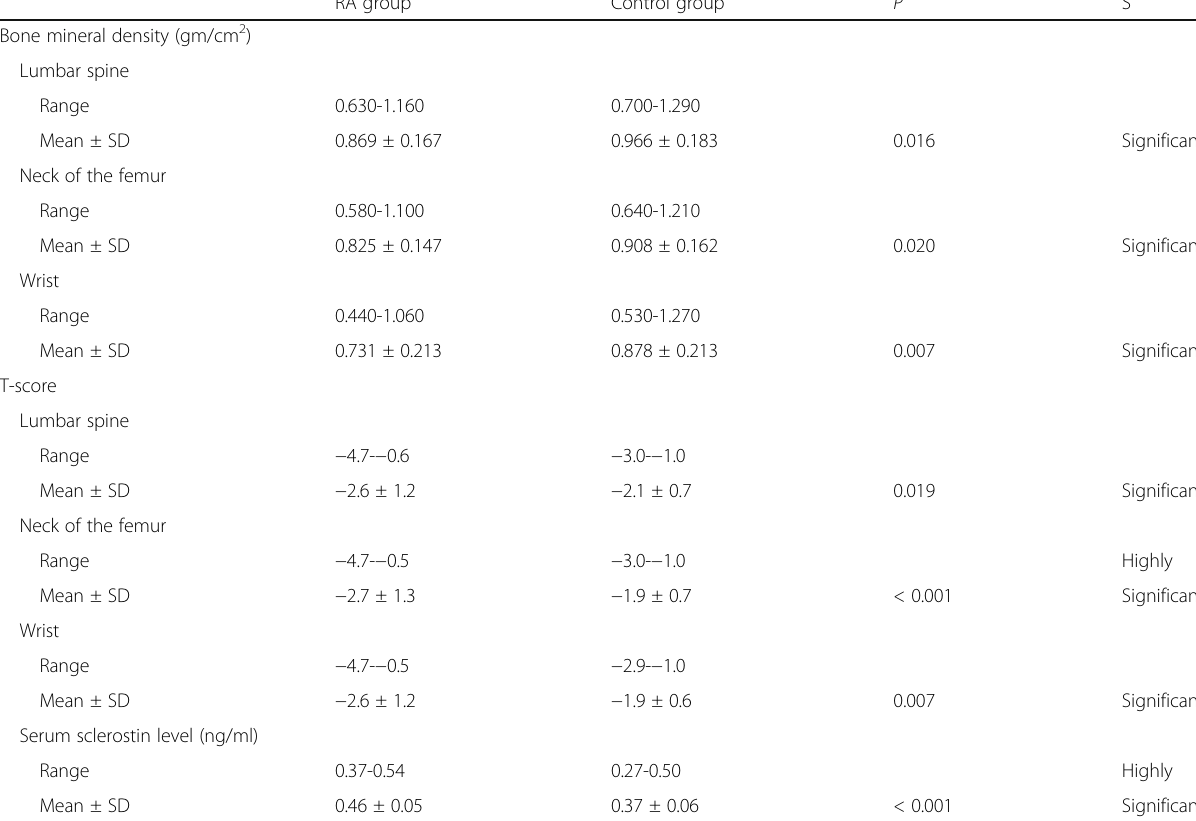
Table 3 Comparison of the DEXA findings and serum sclerostin level between the RA patients and the controls